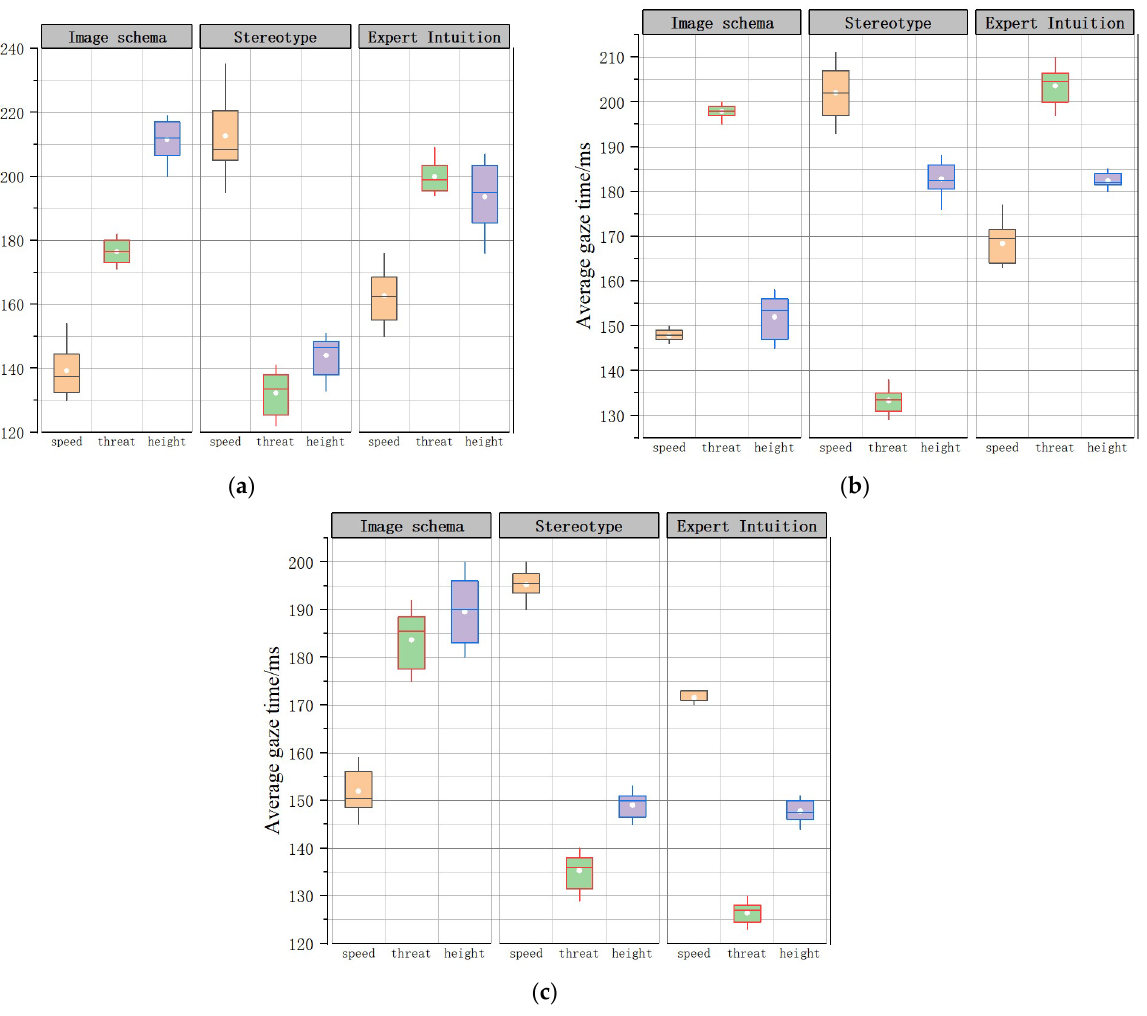
Figure 5. Average gaze time. ( a ) 2000 ms; ( b ) 4000 ms; ( c ) 6000 ms.